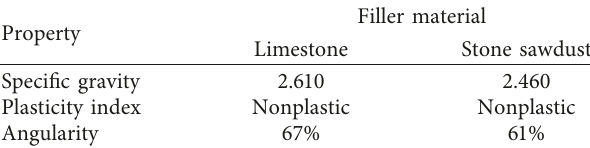
Figure 2: Dynamic shear rheometer (DSR).